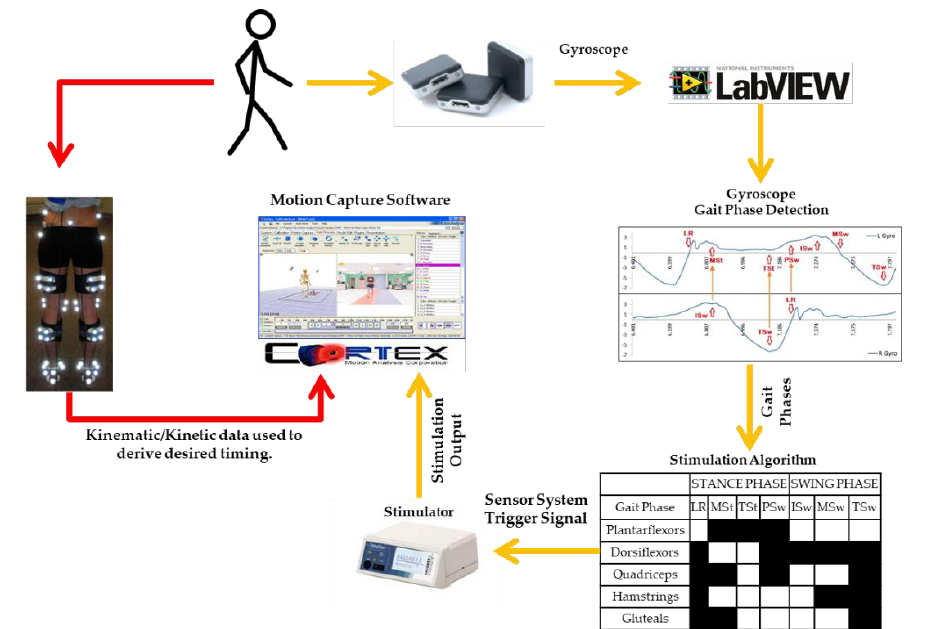
Figure 2. Schematic of the comparison between the stimulation signal of the FES system (yellow arrows) and the desired stimulation timing derived from motion capture data (red arrows).